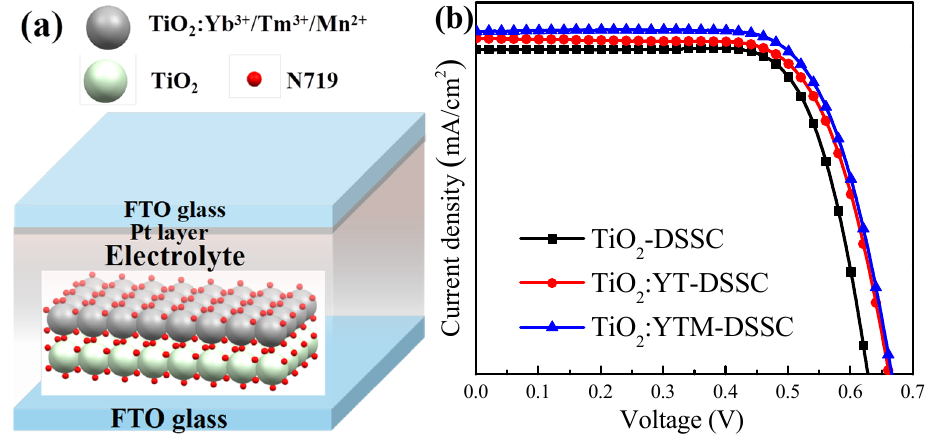
Figure 5. ( a ) A schematic design of the double-layered DSSC structure; ( b ) I-V curves of TiO 2 -DSSC, TiO 2 :YT-DSSC and TiO 2 :YTM-DSSC. TiO 2 :YT-DSSC and TiO 2 Table 1. The performances of TiO 2 -DSSC, TiO 2 :YT-DSSC and TiO 2 :YTM-DSSC, and the perfor- mances of DSSCs with double-layered photoanodes and DSSCs with UC layers.